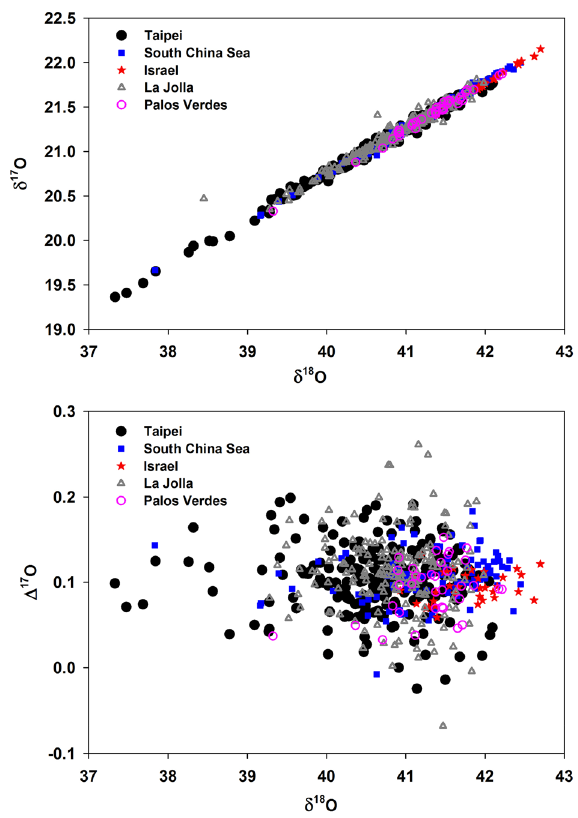
Figure 1. Top: δ 17 O vs. δ 18 O plot for atmospheric CO 2 collected from Taipei (Taiwan), South China Sea, Jerusalem (Israel), La Jolla (United States), and Palos Verdes (United States). Values in ‰ are referenced to VSMOW. Bottom: The reported Δ 17 O values. External measurement uncertainty is ~ 0.05‰ for δ 17 O and δ 18 O and ~ 0.01‰ or less for Δ 17 O. The two anomalous points (two triangles well above the others in the top panel) from La Jolla are beyond the plotting range of Δ 17 O and not shown. See Table 1 for the sources of the data. Note that the δ 17 O values have been rescaled from Liang et al. 17 See text for